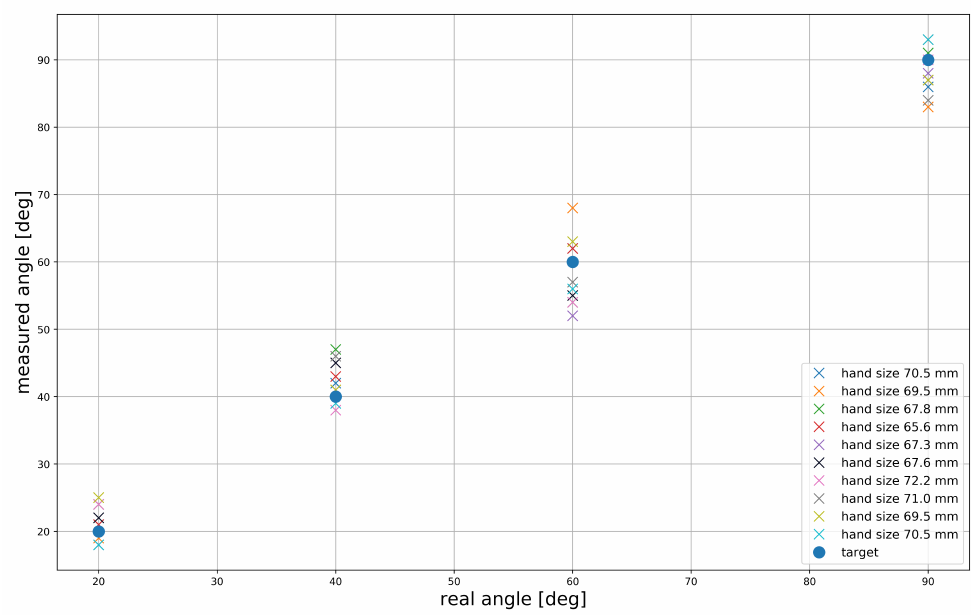
Figure 10. Mean error for flexion and extension in terms of real angle and measured